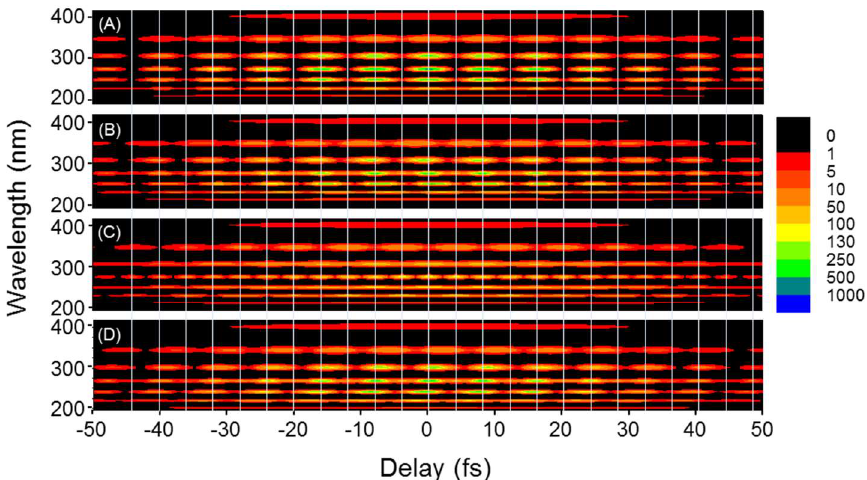
Figure 7. FROG traces calculated under different relative phase. ( A ) 0, 0, 0 ( B ) π/2, 0, 0 ( C ) π, 0, 0 ( D ) 3π/2, 0, 0.